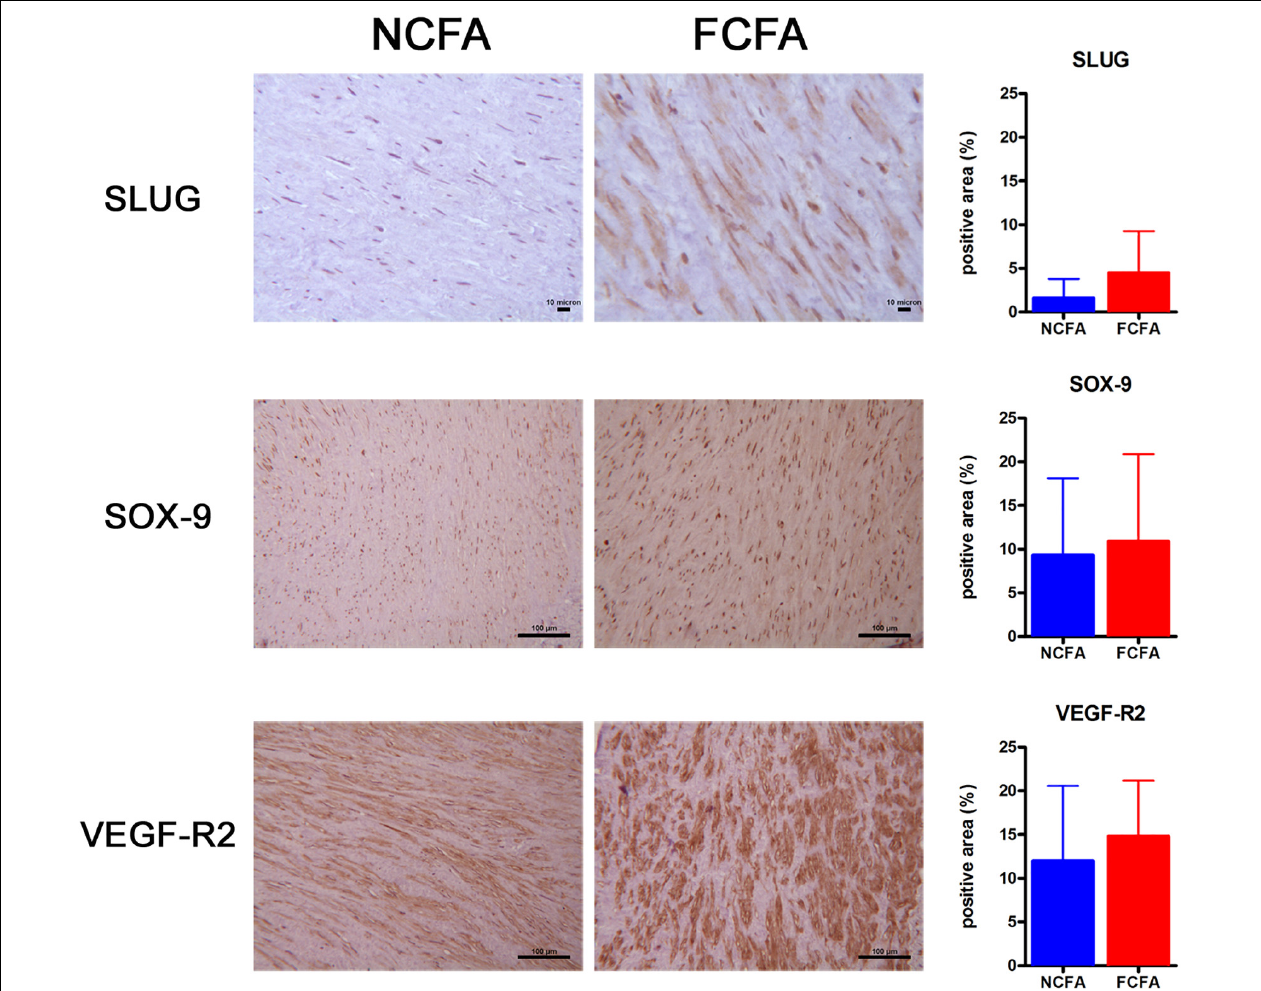
FIGURE 2 | The immunohistochemical analysis of the entire arterial wall showed increased positivity for SLUG, a marker of EndMT, in the focally calcified femoral arteries (FCFA, n = 20) ( p = 0.0006). Positivities observed for SOX-9 and VEGF-R2 showed no significant change between FCFA and not calcified femoral arteries (NCFA, n = 20), although the FCFA showed a trend of greater expression. Scale bar for SLUG = 10 µ m; scale bar for SOX-9 and VEGF-R2 = 100 µ